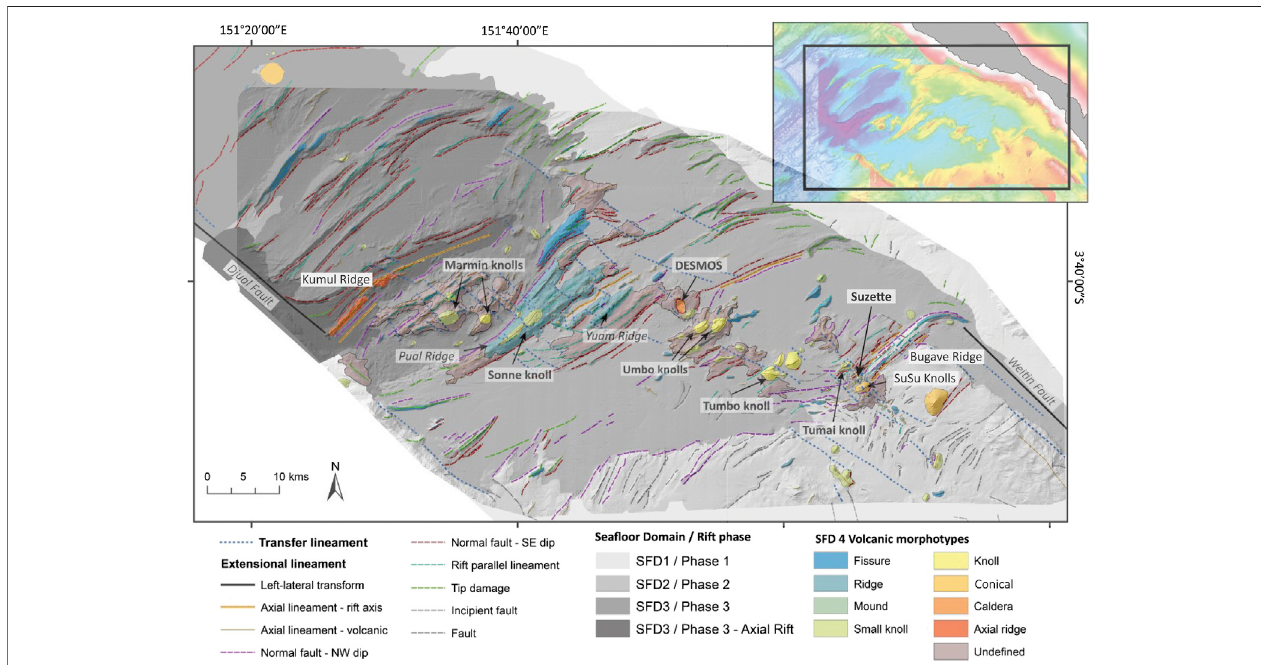
FIGURE 8 | New morphotectonic map of the EMB. Interpretation of SFD is shown in terms of rift phase. SFD4 (volcanic edi fi ce types) are also shown and their corresponding relationship to rift phase or SFD. Lineament interpretation is also shown. Inset consists of compiled DEMs.